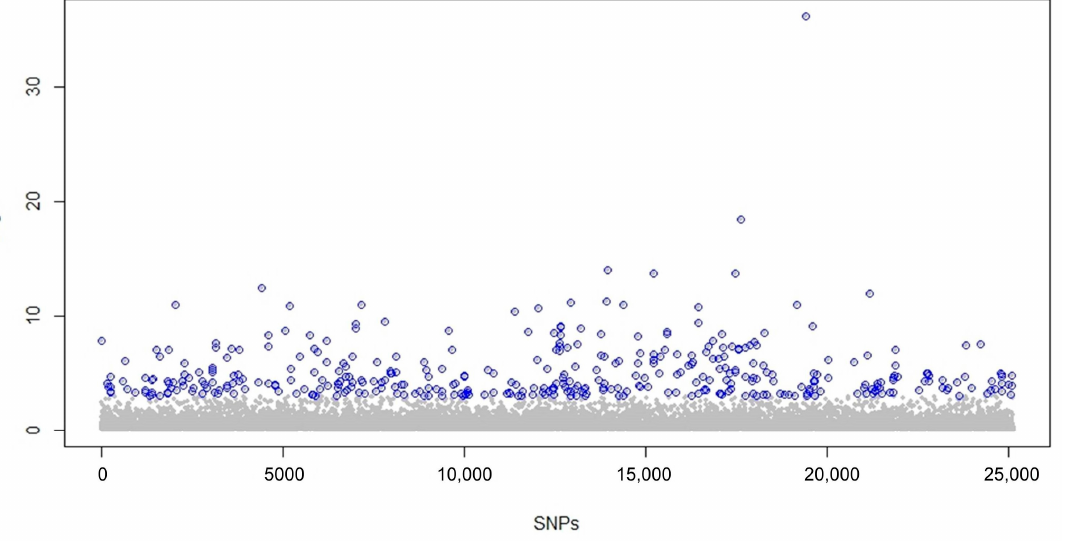
Figure 4. Distribution of the statistical significance score for each marker based on their p -values obtained in PCAdapt; 423 outlier SNPs are highlighted in blue after applying the false discovery rate (FDR) cut-off with a q -value <